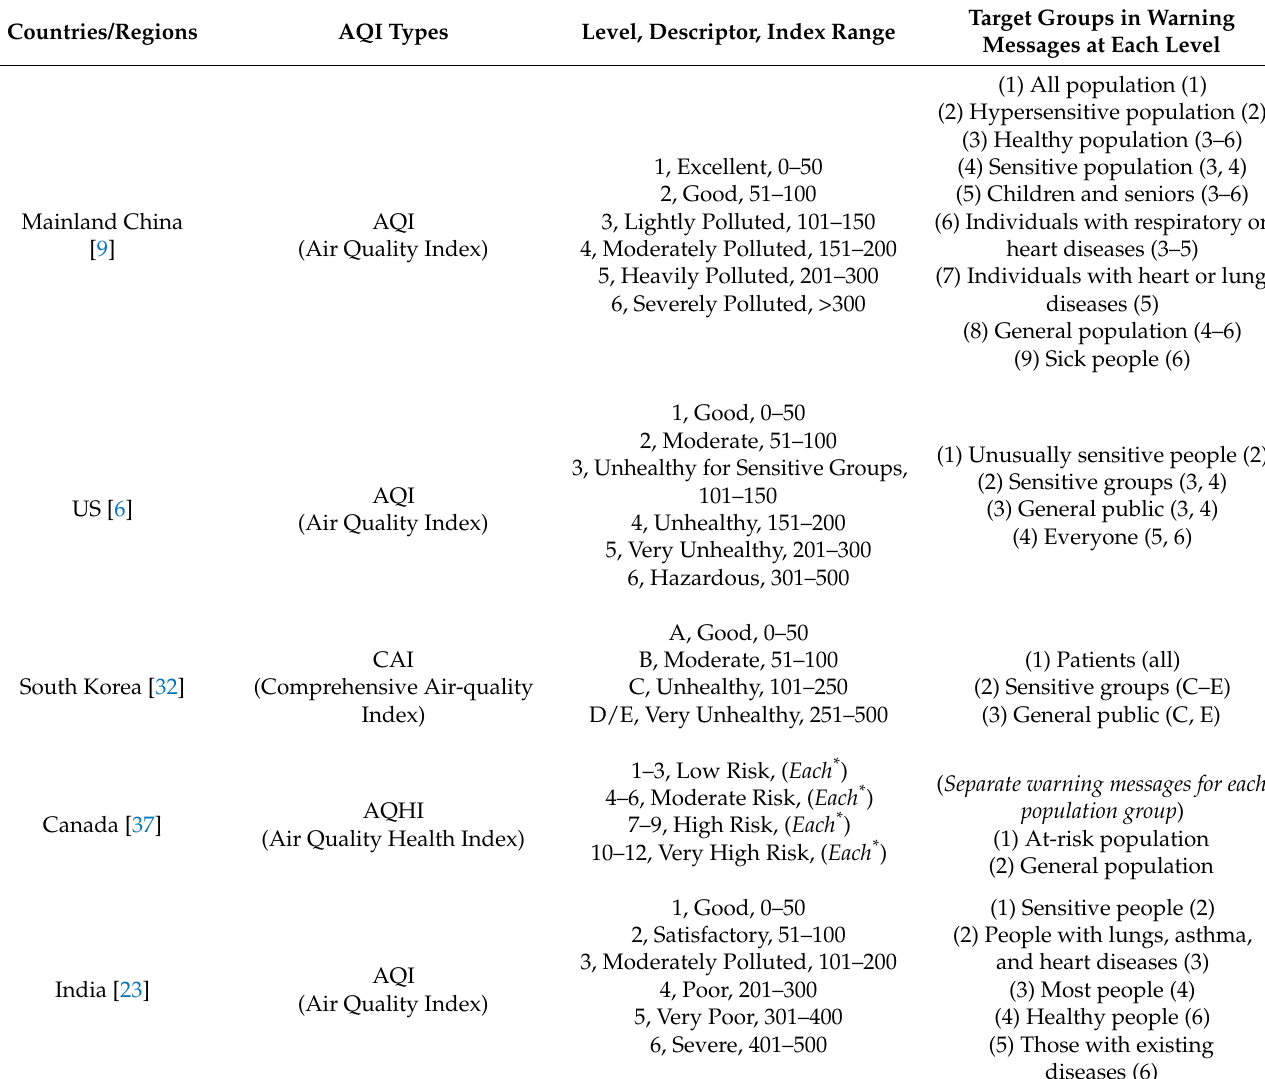
Target Groups in